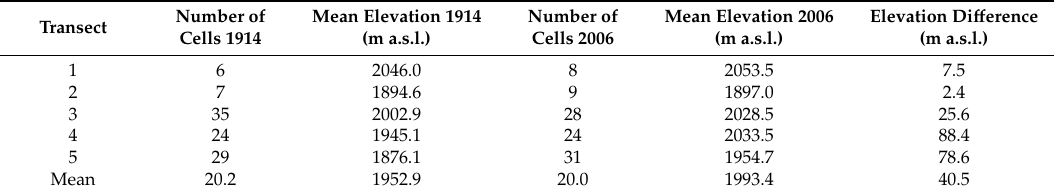
Table 5. Differences in mean elevation, between 1914 and 2006, across transects of cells in unburned areas, which represent the advanced of timberline, the lower boundary of ATE.